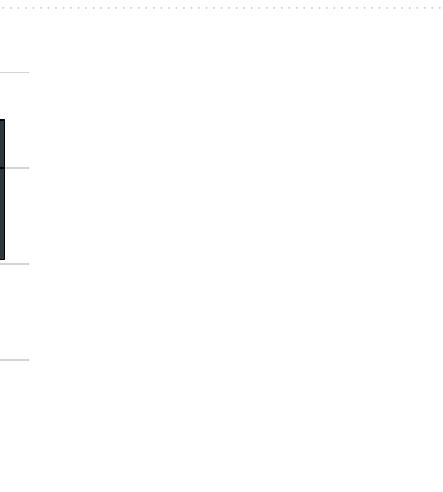
Figure 3. Boxplot showing continuous grades of the participants per group. Every dot represents a participants’ grade with higher grades being better (ranging from 1.0 to 6.0). Note. Median is represented by the bold line within the box and upper/lower quartiles mark the end of the box. CG control group, IP imaginary pill, OLP open-label placebo.